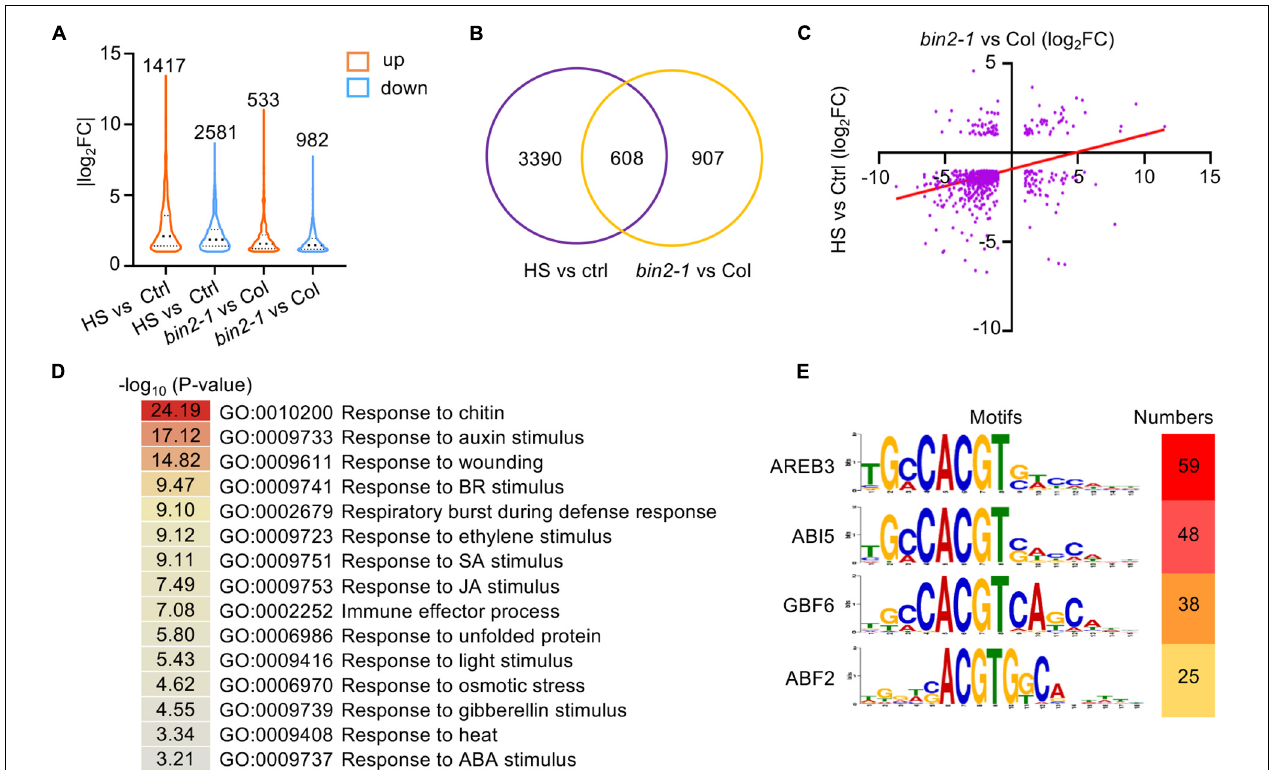
FIGURE 5 | Transcriptome analysis of HS- and BIN2-regulated genes. (A) The numbers and distribution of HS- and BIN2-regulated genes. One-week-old seedlings grown on 1/2 MS agar medium were treated with (Col-0) or without ( bin2-1 and Col-0) HS at 37 ◦ C for 1 h. (B) A Venn diagram showing the number of genes that were differentially regulated by HS treatment or the bin2-1 mutation. (C) The relative expression levels of the 608 HS and BIN2 coregulated genes shown in panel (B) . X -axis: the relative expression levels determined by comparing HS-treated and untreated Col-0 seedlings. Y-axis: the relative expression levels determined by comparing bin2-1 and Col-0 plants grown at 22 ◦ C. (D) GO classification of the 608 HS and BIN2 coregulated genes. (E) The top four enriched cis -elements in the 608 HS and BIN2 coregulated genes are